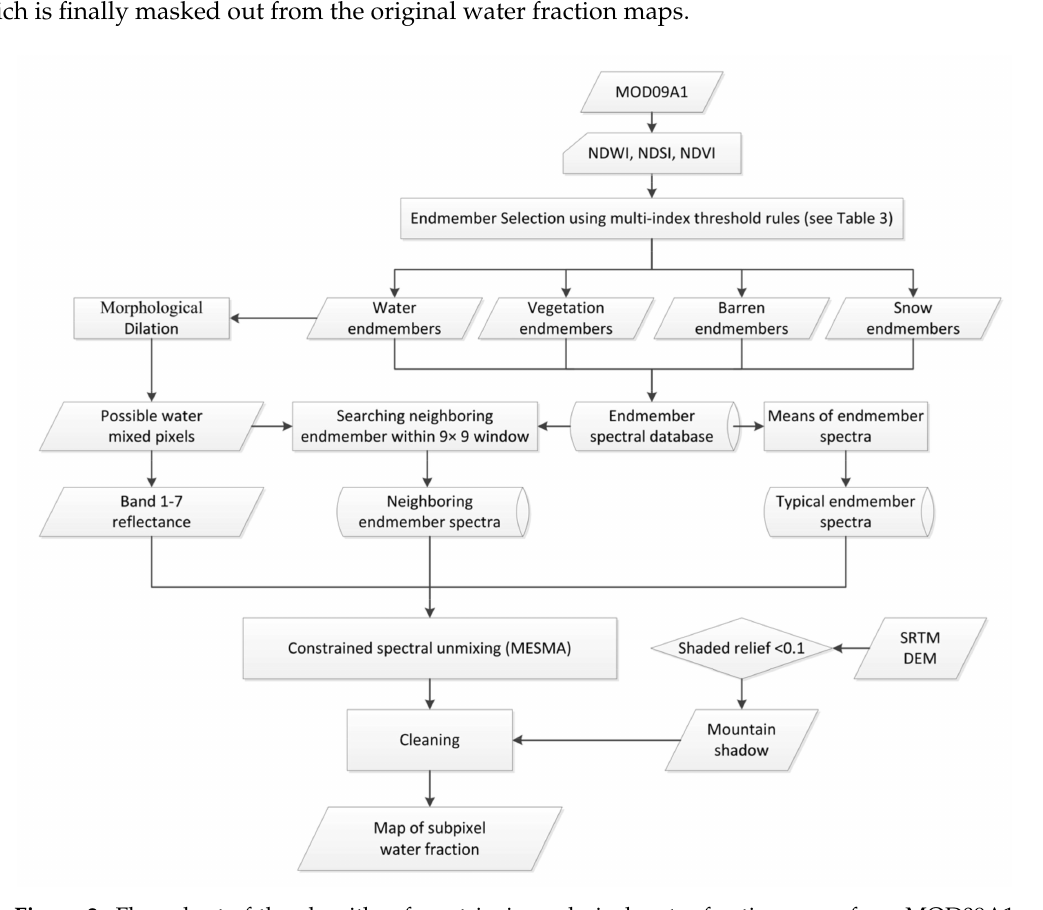
Figure 2. Flow chart of the algorithm for retrieving subpixel water fraction maps from MOD09A1 product. Abbreviations: NDWI, Normalized Di ff erence Water Index; NDSI, Normalized Di ff erence Snow Index; NDVI, Normalized Di ff erence Vegetation Index; SRTM, NASA Space Shuttle Radar Terrain Mission; DEM, digital elevation